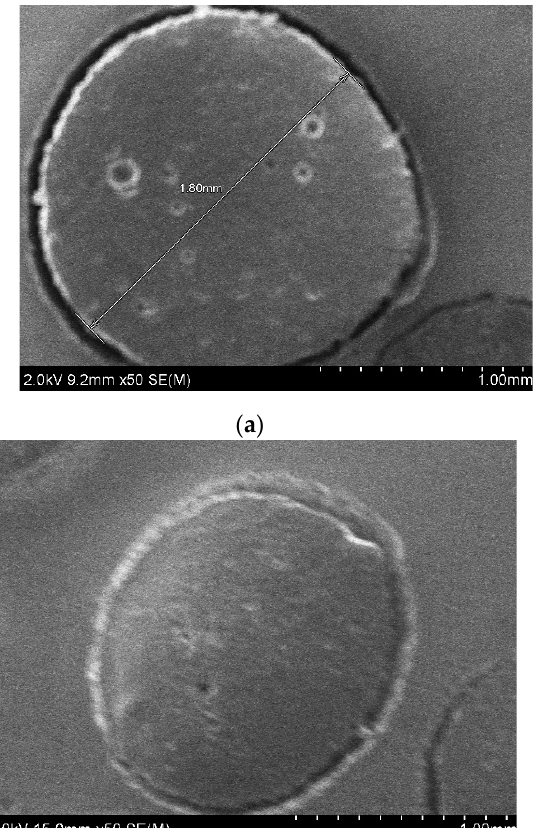
Figure 9. ( a ) Capsule image, ( b , c ) cross section of the microscopic (SEM) image of the capsule.